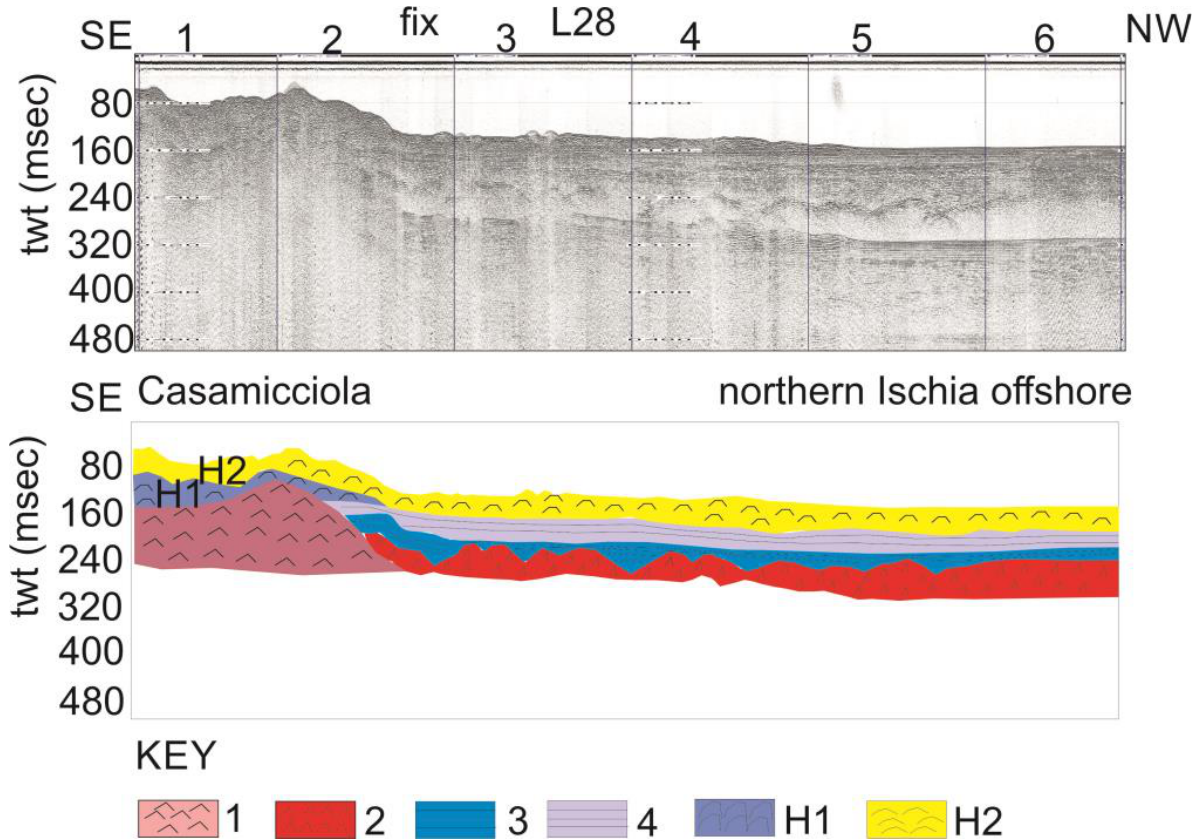
Figure 8. Seismic profile L28 (northern Ischia) and corresponding geologic interpretation. During the eruptive phases following the eruption of the Epomeo Green Tuffs (55 ky B.P.), the La Guardiola lava has been overlain by the Monte di Vezzi Formation, composed of not welded pumice flows erupted from the Epomeo Green Tuff, by the S. Costanzo Formation, composed of white tuffs, well stratified, with pumice, by the Monte di Vezzi Formation, composed of well-bedded pumice fall breccias and brown scoria layers and by the Piano Liguori Formation, composed of inter-layered white ashes and pumice layers. Four units have been recognized (“Barano 1” and “Barano 2” volcanic acoustic base- ment, pyroclastic sequence and marine sequence). The Barano 1 and Barano 2 units have been, respectively, correlated with the Upper Scarrupata di Barano Formation and with the Lower Scarrupata di Barano Formation, which are both composed of tuffs and breccia. These two thick sequences are overlain by a sequence, probably pyroclastic in nature, characterized by parallel horizons. These sequences are overlain by the youngest unit, interpreted as a marine